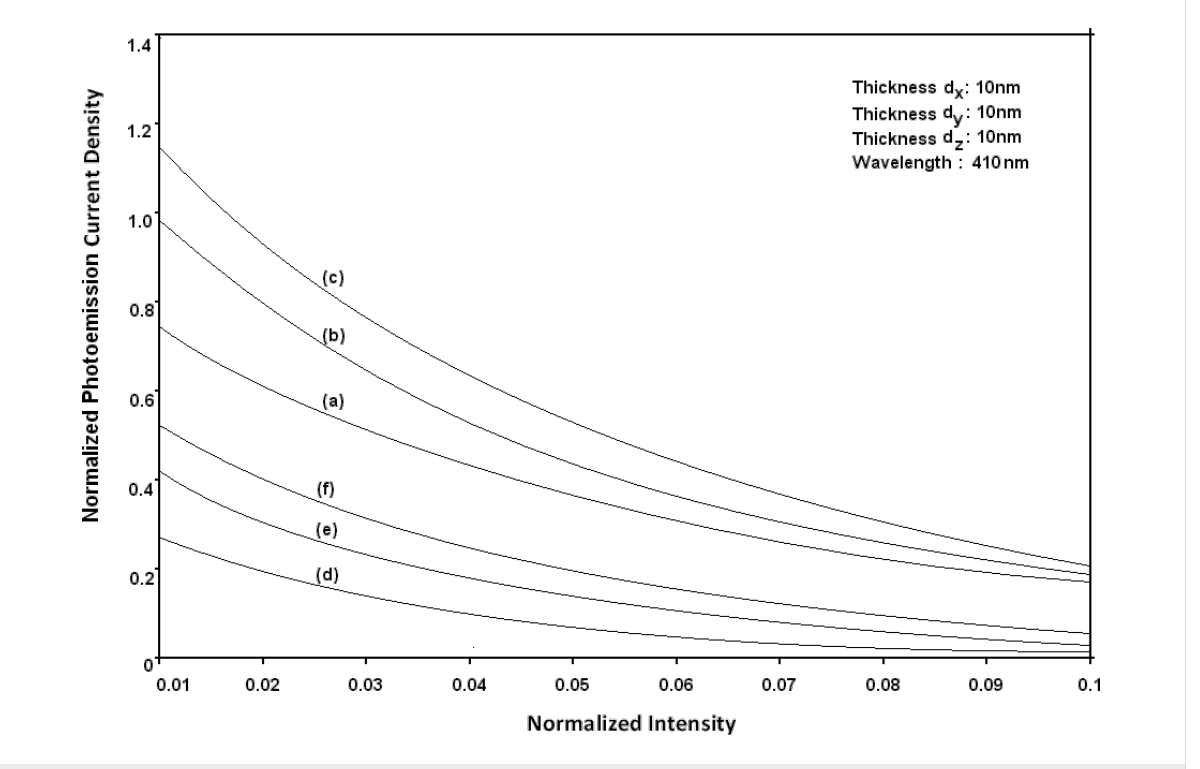
Figure 13: Plot of the normalized photoemission current density from quantum dot effective mass superlattices of HgTe/Hg 1 − x Cd x Te and In x Ga 1 − x As/ InP as a function of normalized light intensity for all cases of Figure